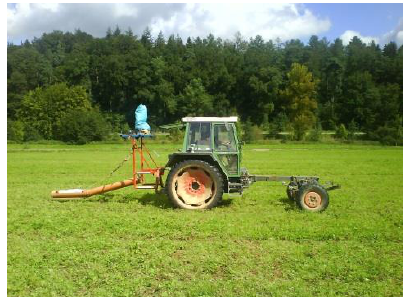
Figure 2. Mounting of the EM38 on a metal-free sledge pulled by a tractor (constructed after Corwin and Lesch [7]).